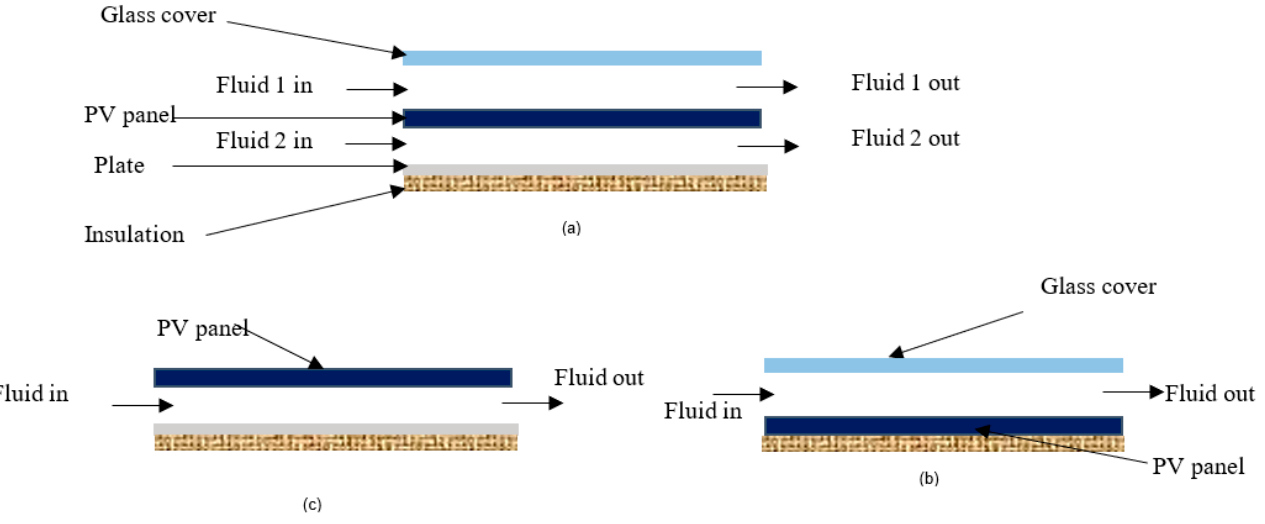
Figure 1. Various PVT pa tt erns ( a ) cooling with two fl uid ( b ) cooling with one fl uid below the panel ( c ) cooling with one fl uid above the